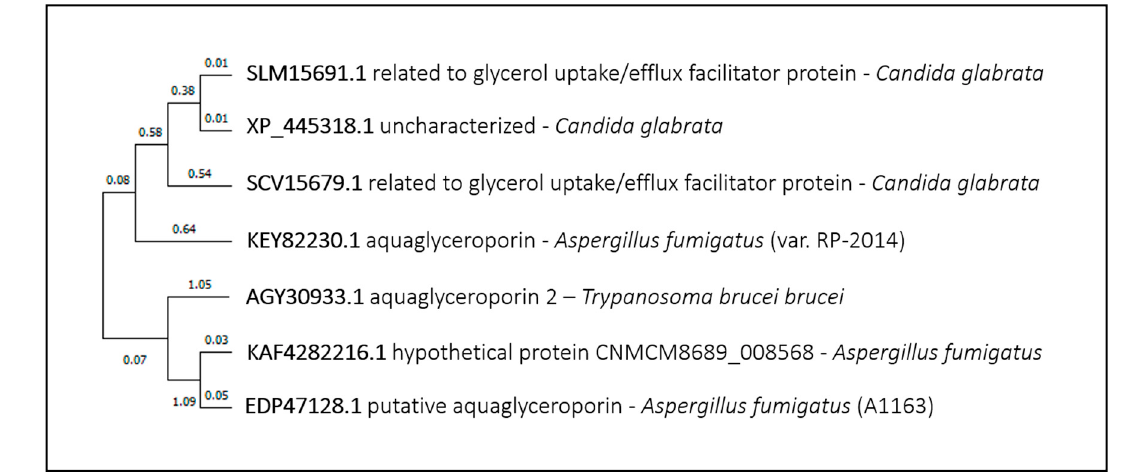
Figure 11. TbAqp2 phylogenetic analysis. The tree with the highest log likelihood is shown. This analysis involved seven amino acid sequences. There were a total of 684 positions in the final dataset. Evolutionary analyses were conducted in MEGA X.